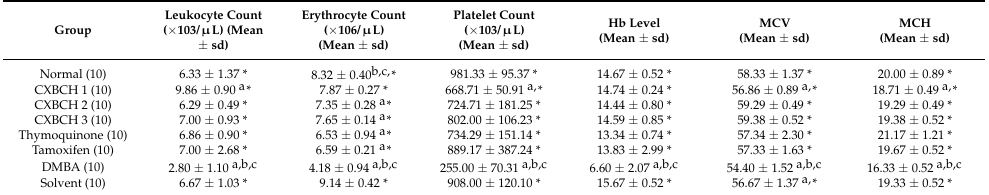
Table 2. Routine blood test results of DMBA-induced SD rats and CXBCH treatment two weeks before and five weeks during induction. Blood sampling was carried out at the 30th week of the experiment. PlateletCount ErythrocyteCount LeukocyteCount HbLevel ( × 103/ µ L) ( × 106/ µ L) Group ( × 103/ µ L)(Mean (Mean ± sd) ± sd) (Mean ± sd) (Mean ± sd)